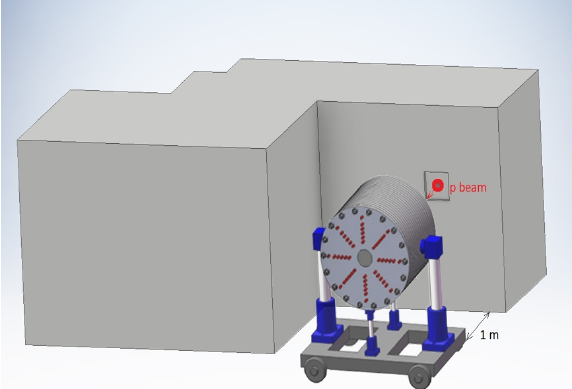
Figure 8. B-URAN surroundings including concrete shielding [8]